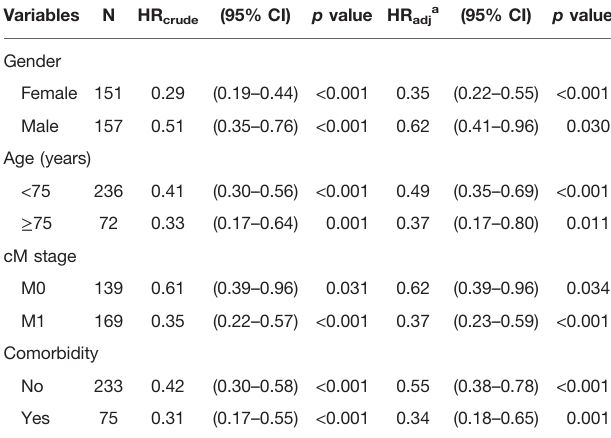
TABLE 3 | Multivariate Cox regression analysis of 3-year overall survival in patients receiving CT+NU compared with CT alone strati fi ed by patient